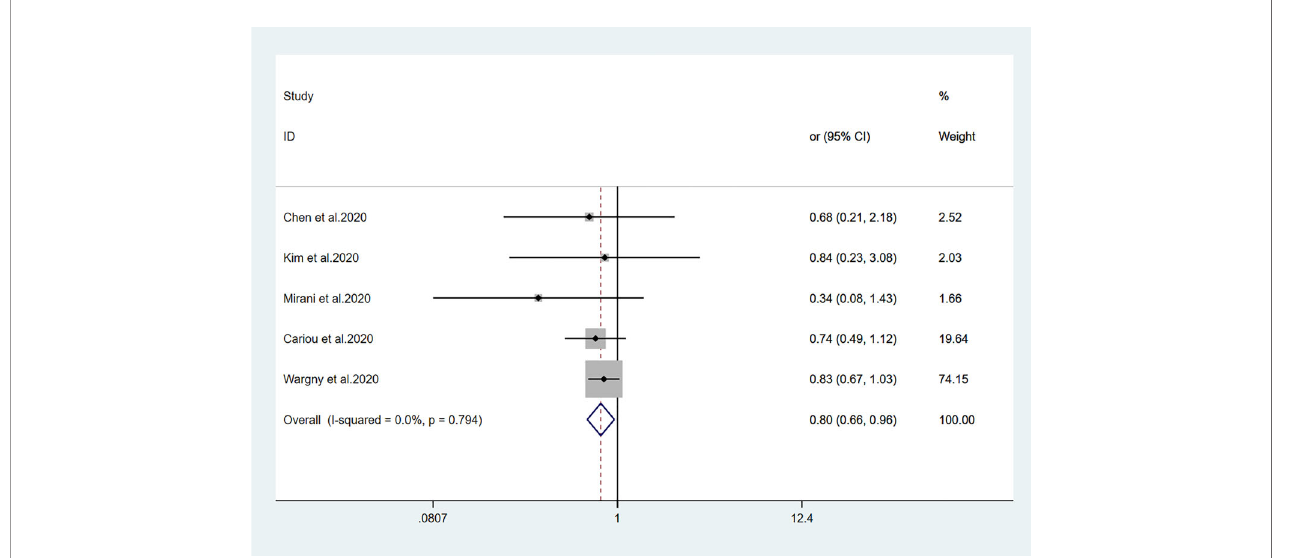
FIGURE 3 | Forest plots of meta-analysis of the relationship between sulfonylurea therapy and the risk of mortality in patients with type 2 diabetes who have COVID-19.